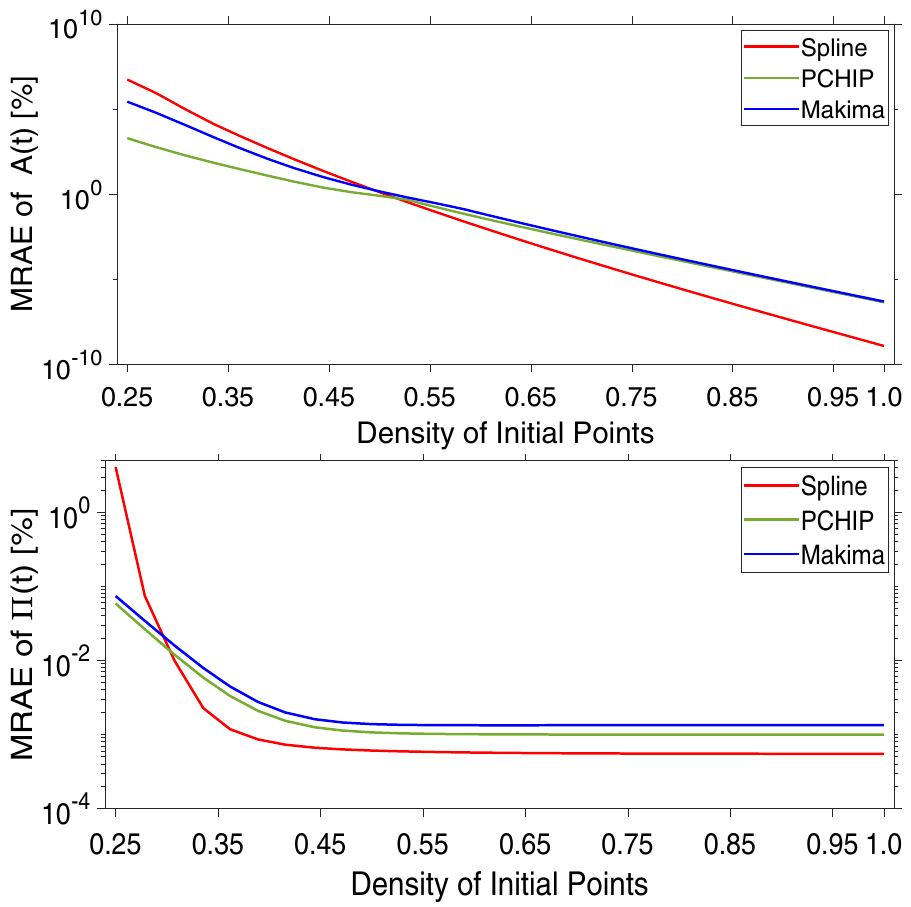
Figure 2. Mean relative absolute error (MRAE) vs. the density of initial experimental points (DIP) of the three MATLAB built-in interpolation functions: Spline, PCHIP and Makima. (Top) The MRAE is evaluated with respect to Eq. (2). (Bottom) The MRAE is evaluated with respect to Eq.